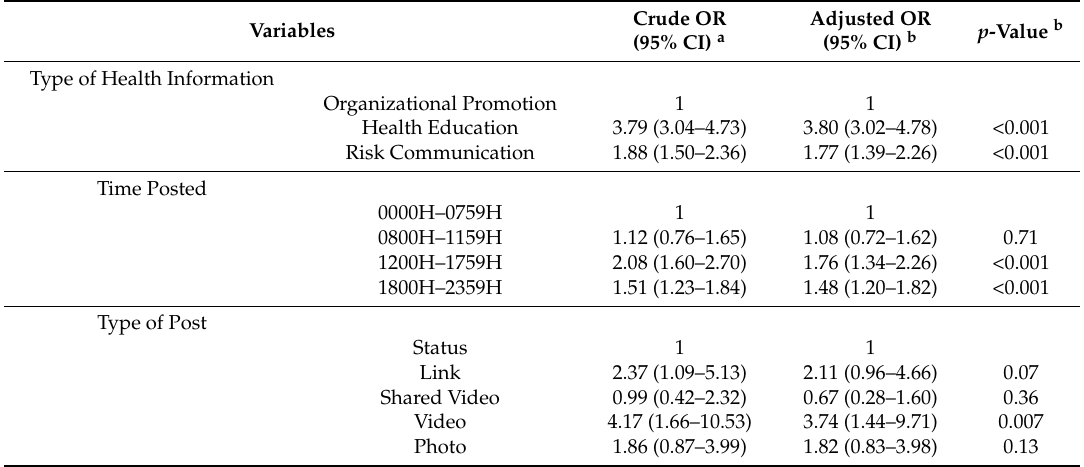
Table 3. Association between type of health information, type of post, time of post, and good engagement rate using